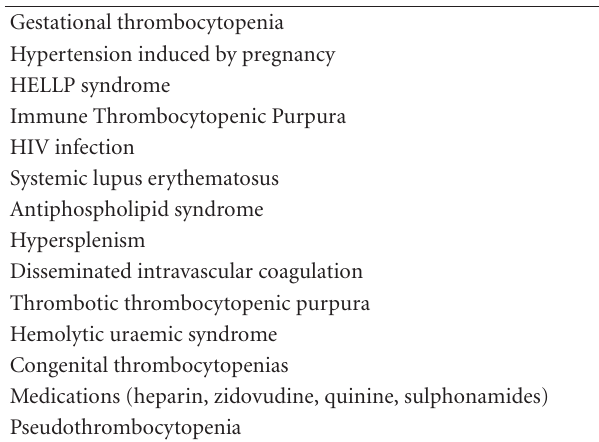
Figure 1: Platelet count.